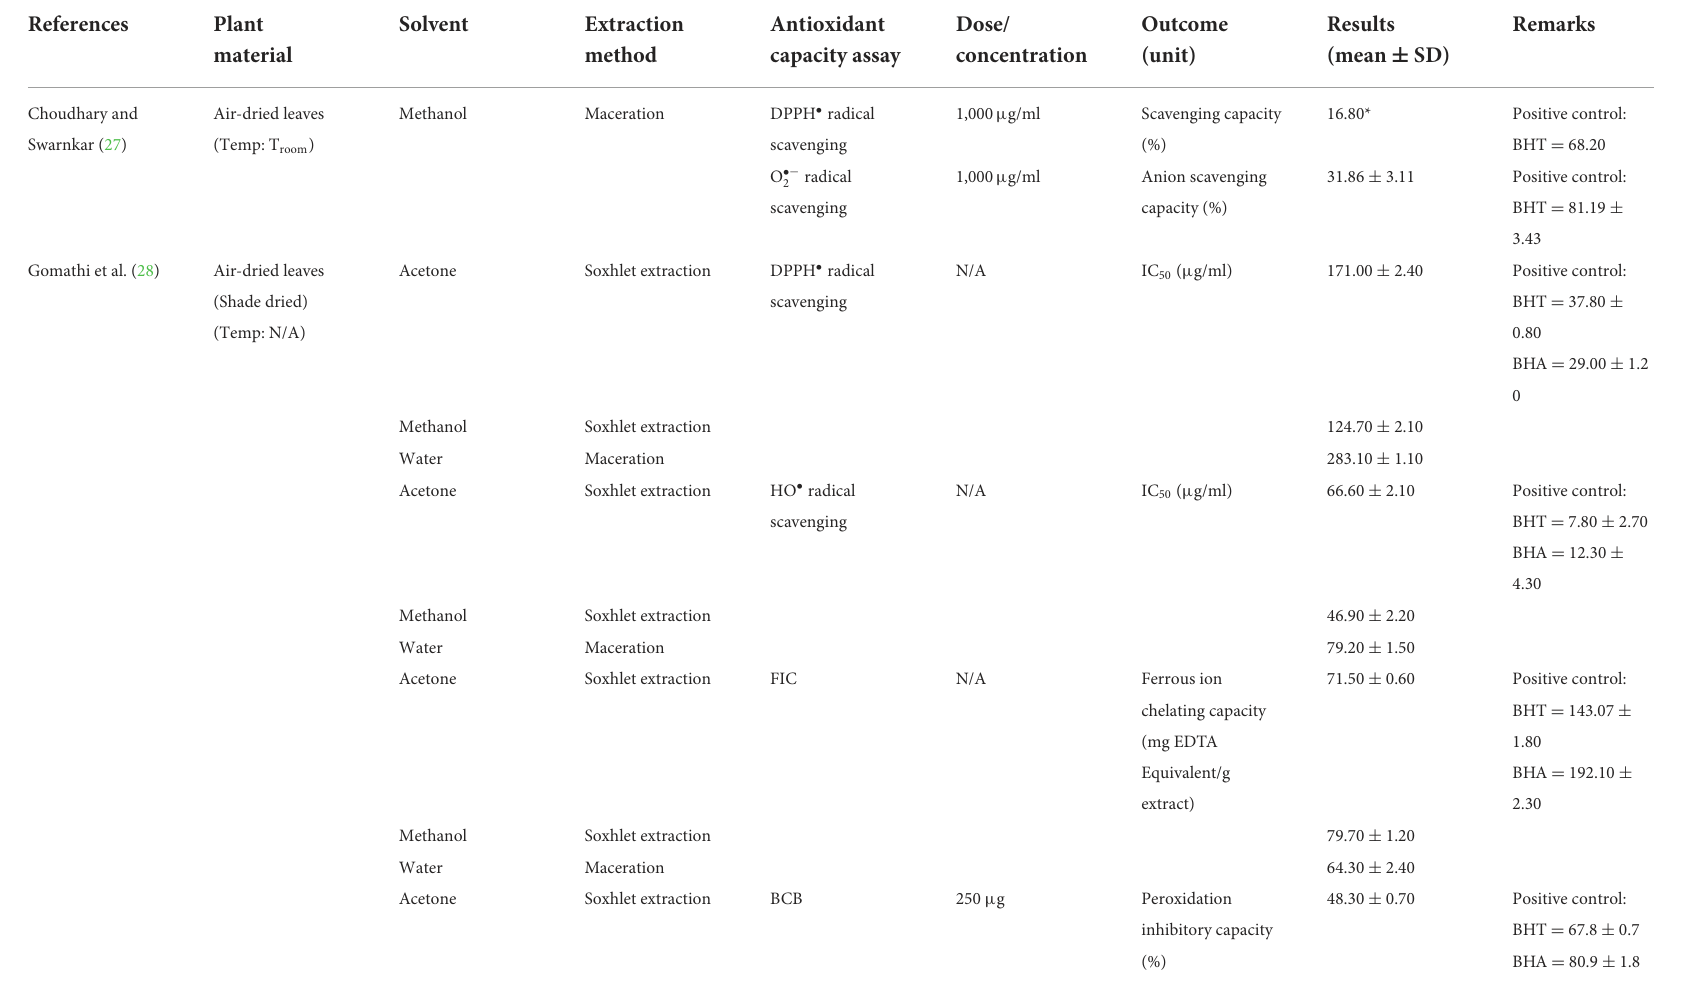
TABLE 1 Study characteristics of the in vitro antioxidant capacity of T. indica leaf